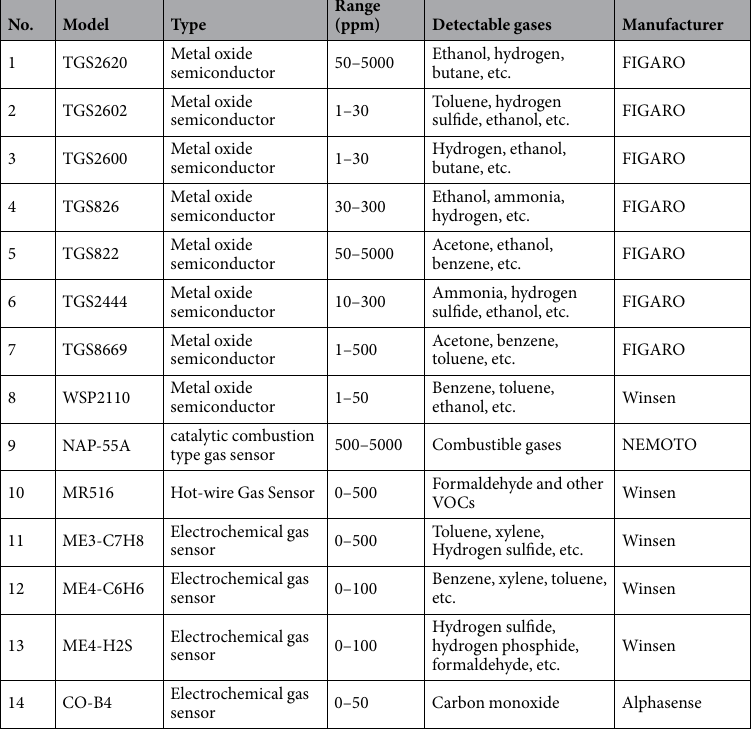
Table 2. Sensors used in this study.